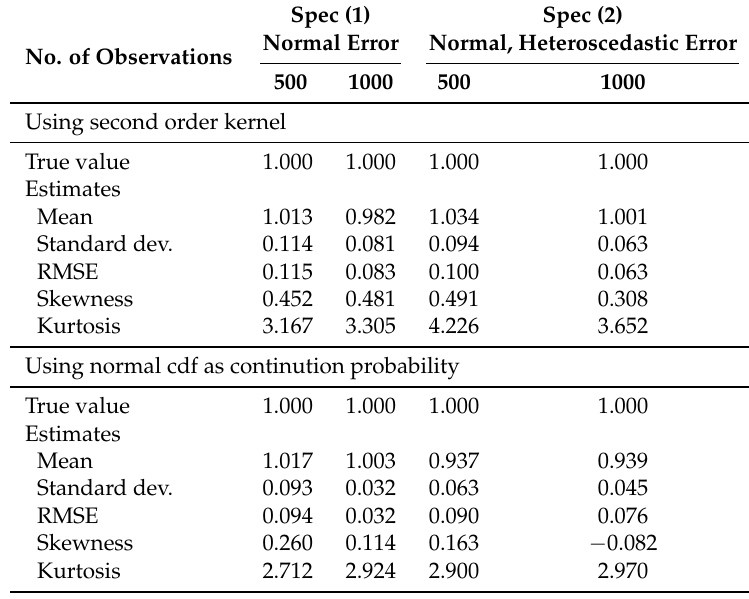
Table 1. Simulation summary statistics—parameter: coefficient on X 2